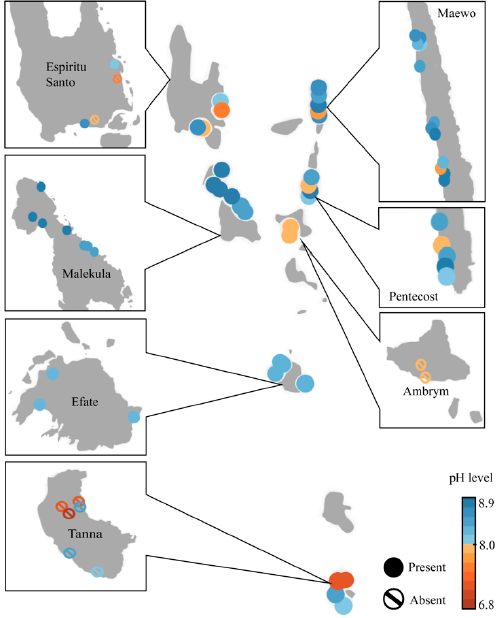
Figure 3. Map of Vanuatu depicting the pH of each collecting locality. Solid circles represent localities where Vanuatubasis was collected, and the circle-backslash symbols represent locations where Vanuatubasis was not found.